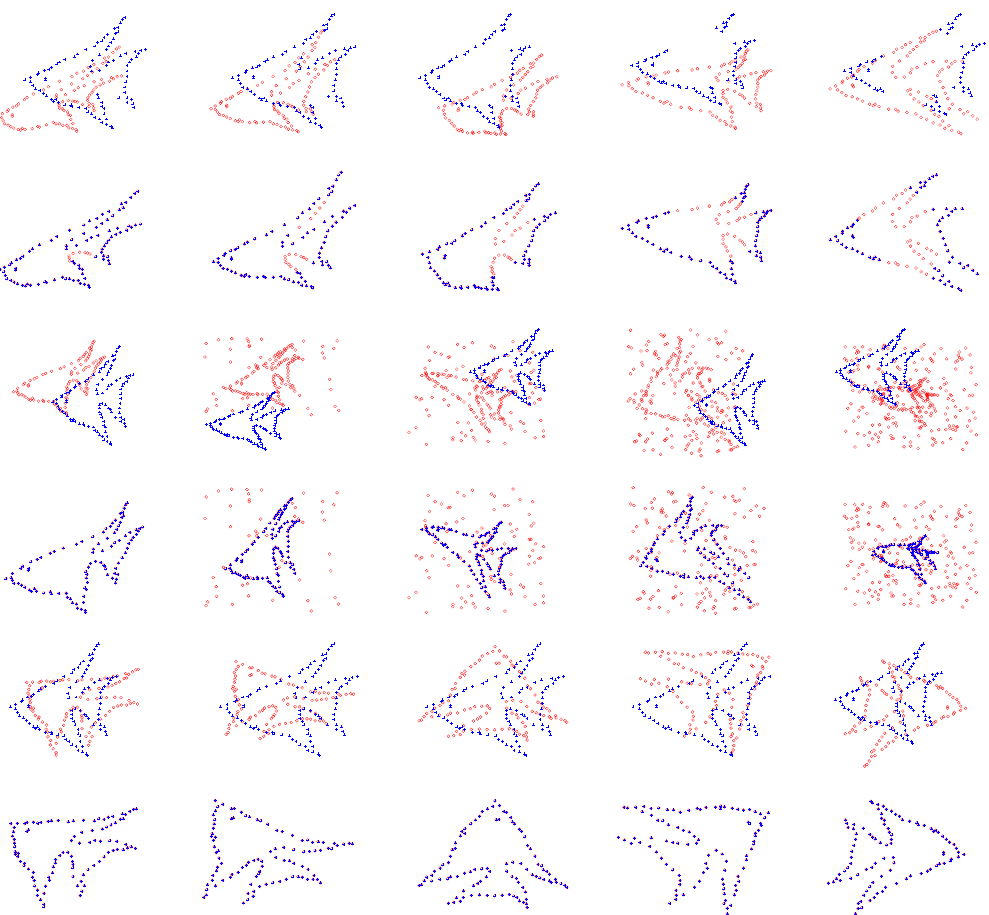
Figure 1. Registration results on fish dataset. From top to bottom: deformation, noise, occlusion, outliers, and rotation in every two rows; the upper row shows the data and the lower row shows the registration results. From left to right, the degradation level becomes larger. The model points and the scene points are marked by “ + ” and “ o, ” respectively.